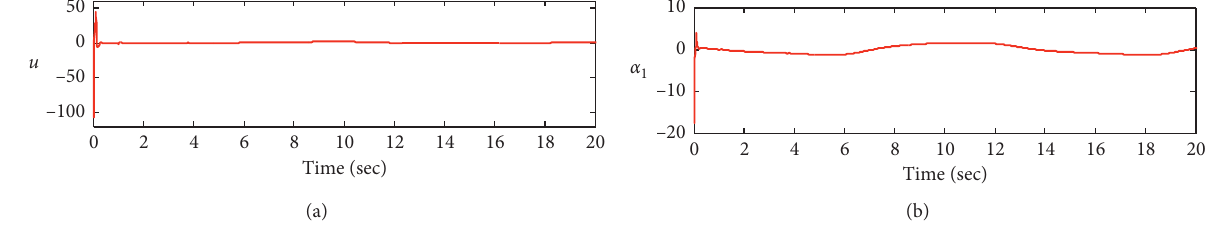
Figure 3: Profiles of control inputs u and α